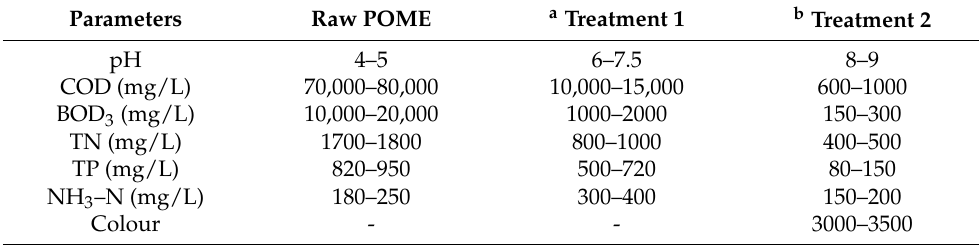
Figure 1. Lab-scale pre-treatment process of raw POME. Table 1. Characteristics of POME before and after the preliminary treatment processes.